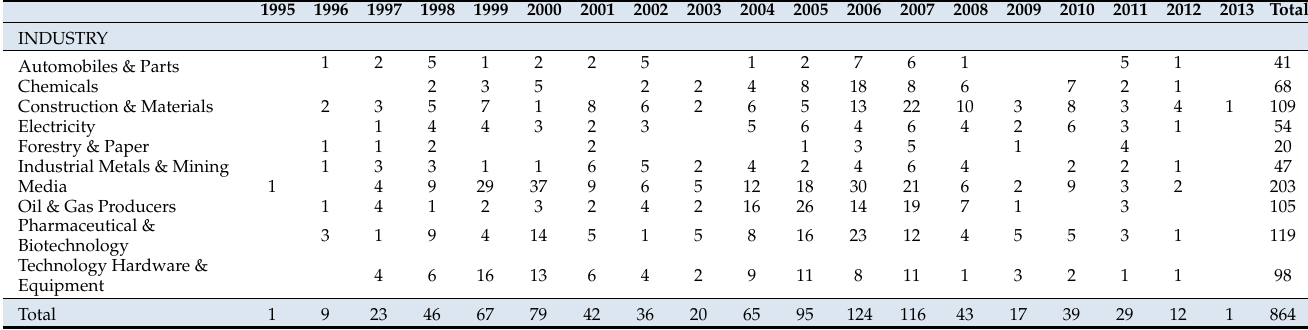
Table 1. Initial Public Offerings by